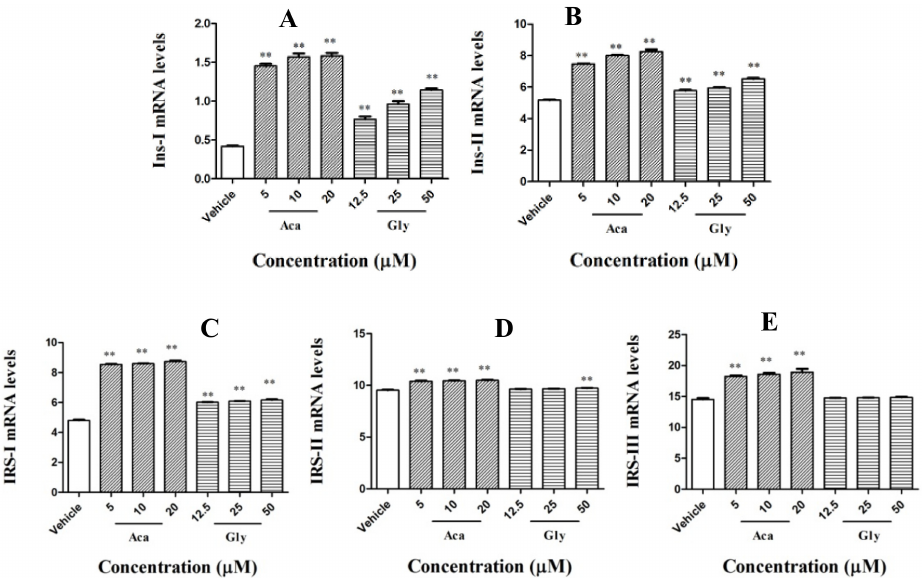
Figure 3. Effects of acankoreagenin on the expression of insulin secretion-related gene in RIN-m5F cells. Expression was determined after culturing the cells in six-well plate containing 20 mM glucose and then treated in the absence (vehicle) or various concentrations of acankoreagenin for 24 h. Expression levels were analyzed by real-time RT-PCR. β -actin mRNA was used as an internal control. ** p < 0.01 versus vehicle-treated cells. Bars indicate SEM ( n = 3).Gly, glybunide; Aca, acankoreagenin. ( A ) Ins-I mRNA expression; ( B ) Ins-II mRNA expression; ( C ) IRS-I mRNA expression; ( D ), IRS-II mRNA expression; ( E ), IRS-III mRNA